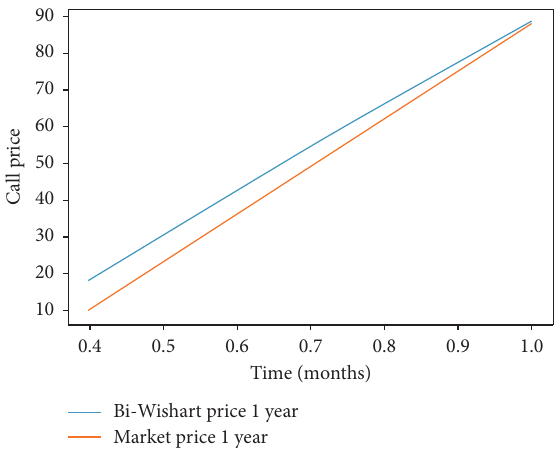
Figure 3: The double Wishart model price predictions and market price at 1 year maturity